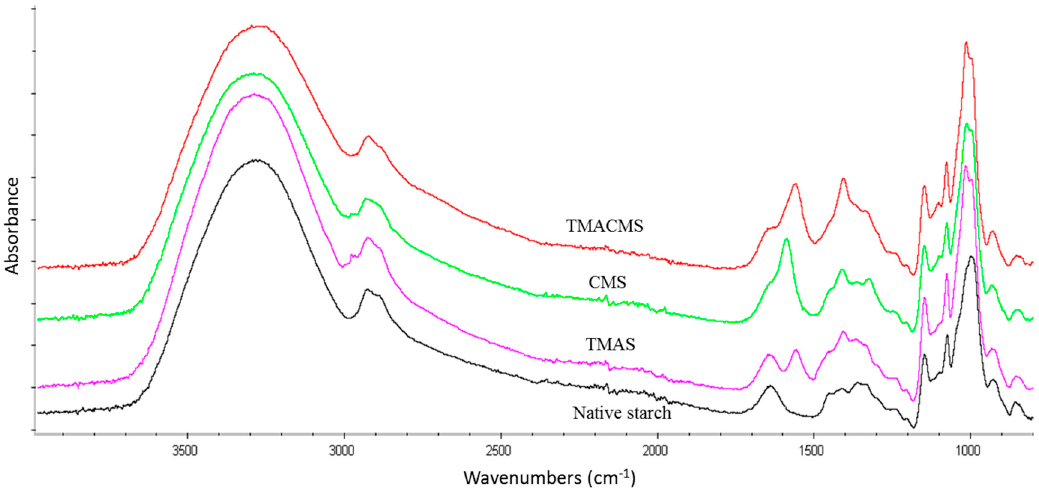
Figure 1. FTIR spectra of native starch (black), trimethylaminestarch (TMAS) (pink), carboxymethylstarch (CMS) (green), and of trimethylaminecarboxymethylstarch (TMACMS) (red).